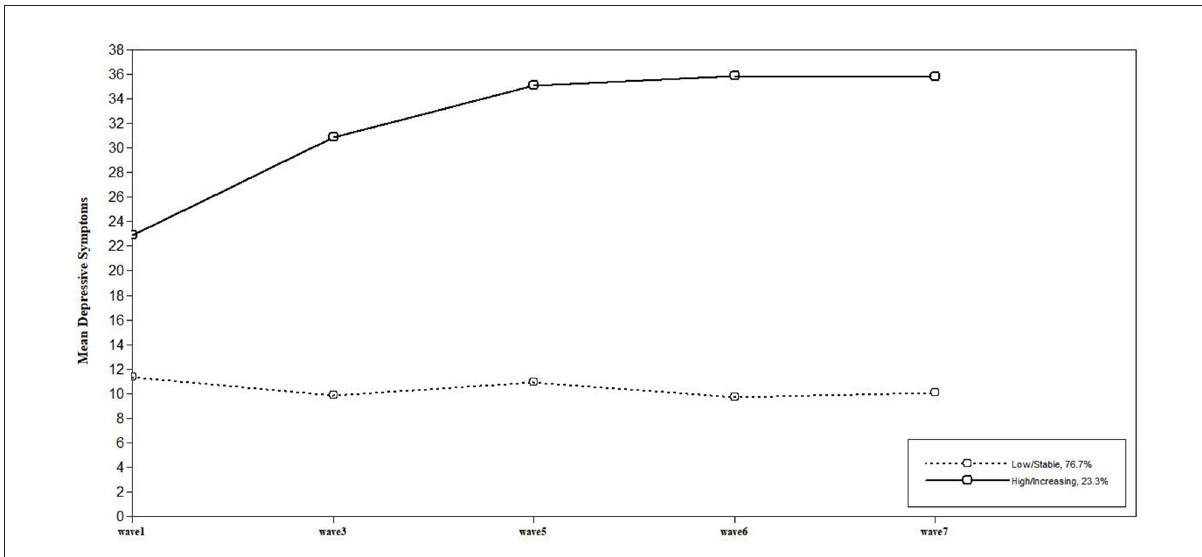
FIGURE1 Two trajectories of depressive symptoms: Class 1. low/stable symptom (76.7%), Class 2. high/increasing symptom (23.3%). Based on the data of five waves, average depression was measured as the CES-D-NK